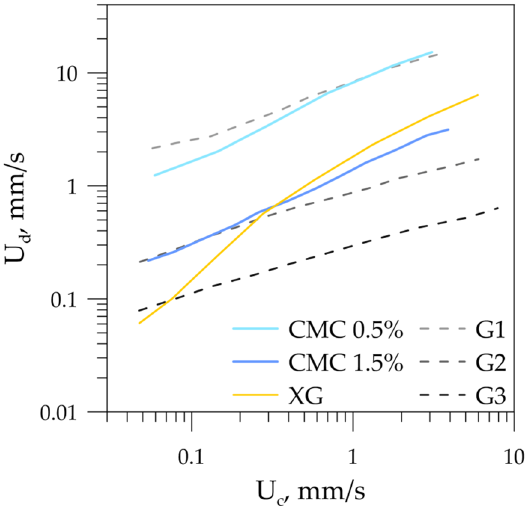
Figure 5. Boundaries between segmented and continuous-flow rates for liquid–liquid flows with Newtonian and non-Newtonian dispersed phases.